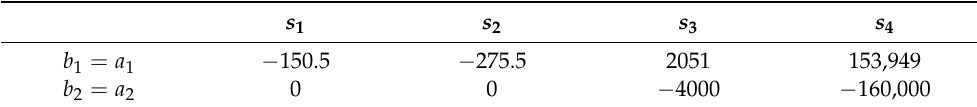
(cid:16) (cid:16) (cid:17)(cid:17) U b j ; s l